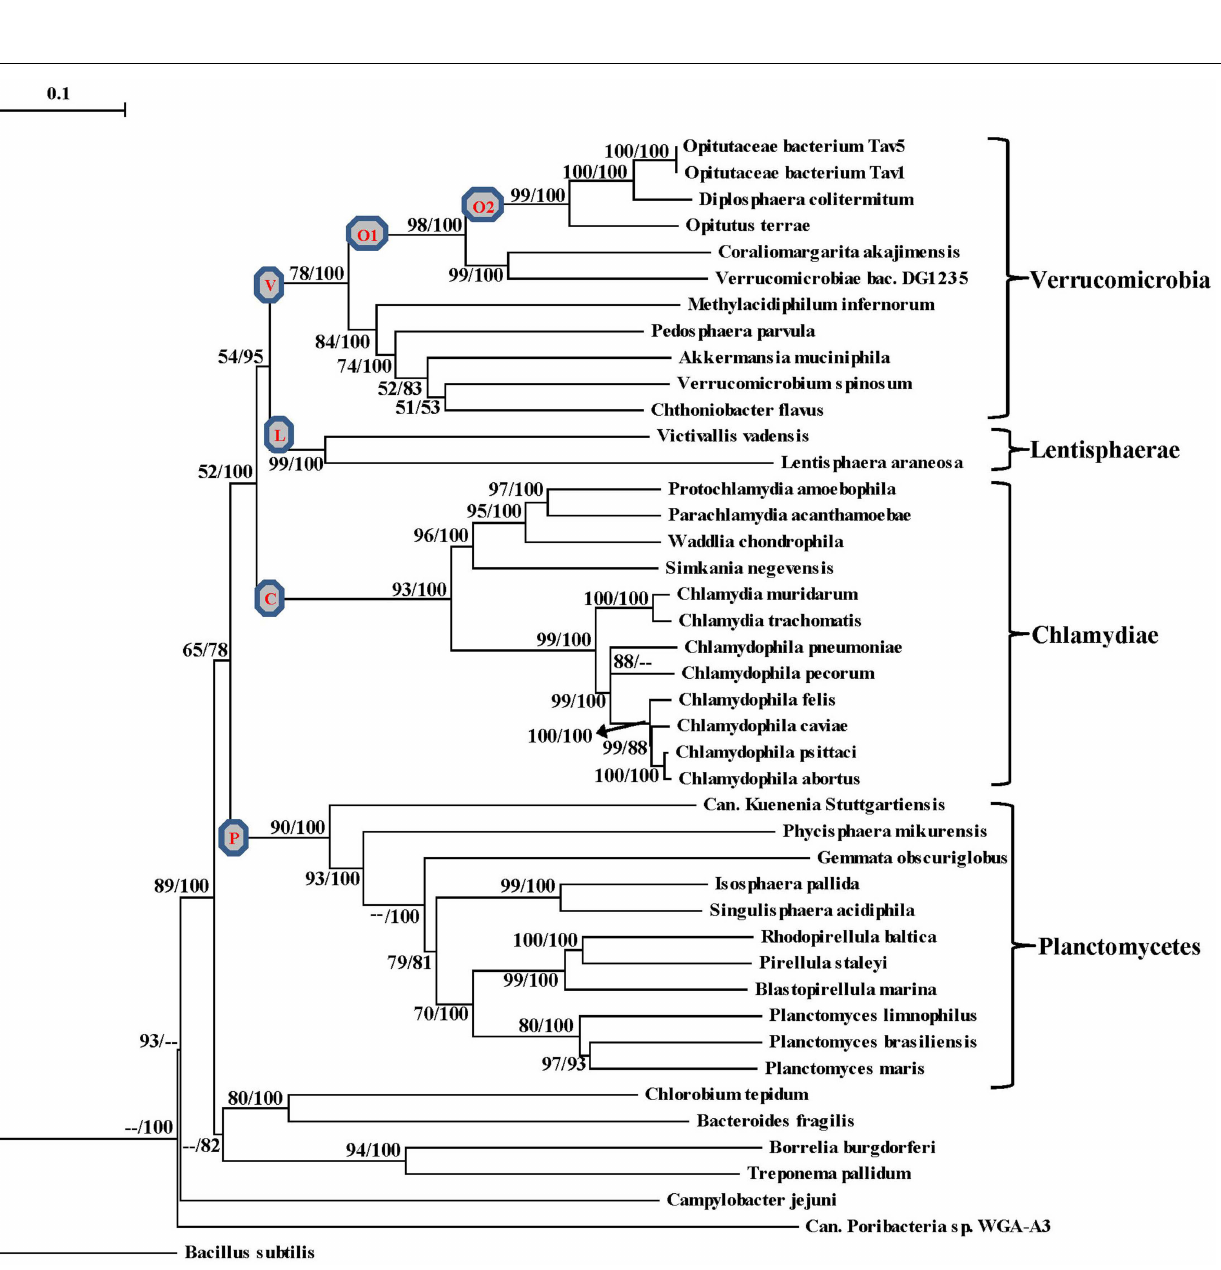
FIGURE 1 |A Neighbor-joining distance tree for the sequenced species belonging to the PVC group of bacteria based upon concatenated sequences for 16 conserved proteins. The numbers on the node indicate% statistical support for different nodes in the ML and NJ analyses, respectively.